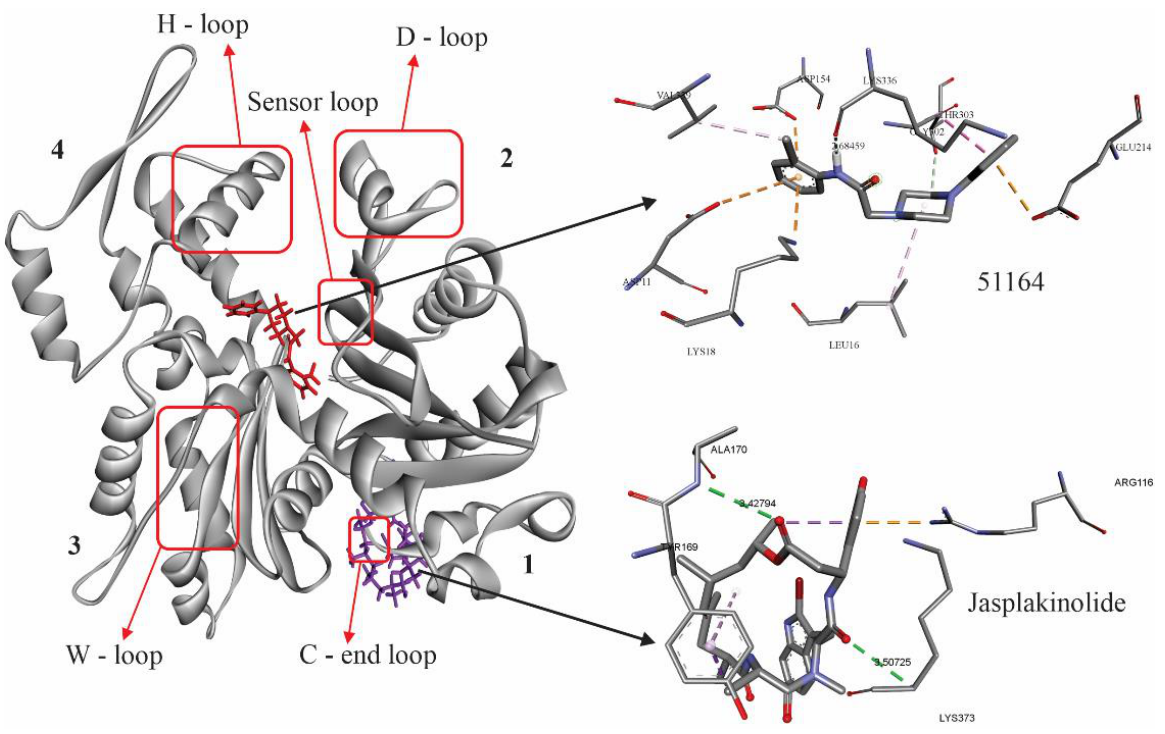
Figure 4. Spatial orientation 51164 (in red) and jasplakinolide (violet) on the G-actin surface, ob- tained by molecular docking. The key loops involved in the polymerization of G-actin are also indicated [50,51]. The numbers show the subdomains of the protein.